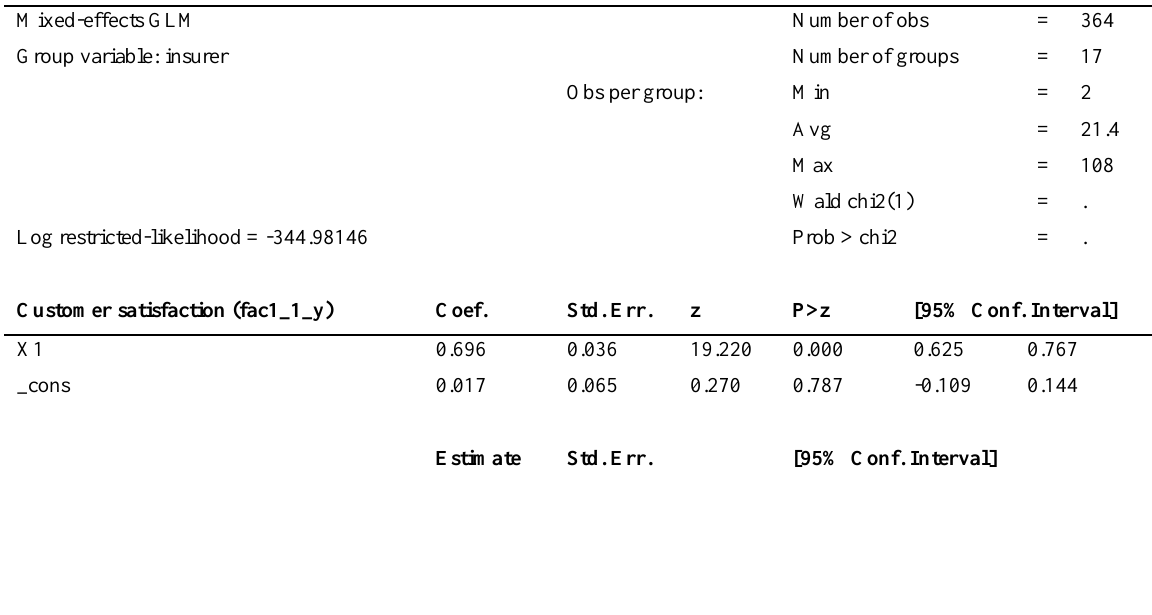
Table 4: Influence of Assurance: fixed effect with random